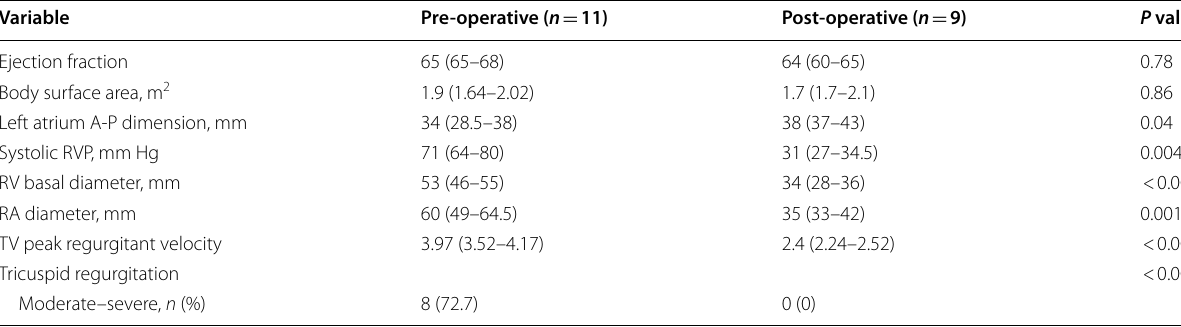
A-P Lung transplant surgery: anterio-posterior, RVP Right ventricular pressure, RV Right ventricle, RA Right atrium, TV Tricuspid valve